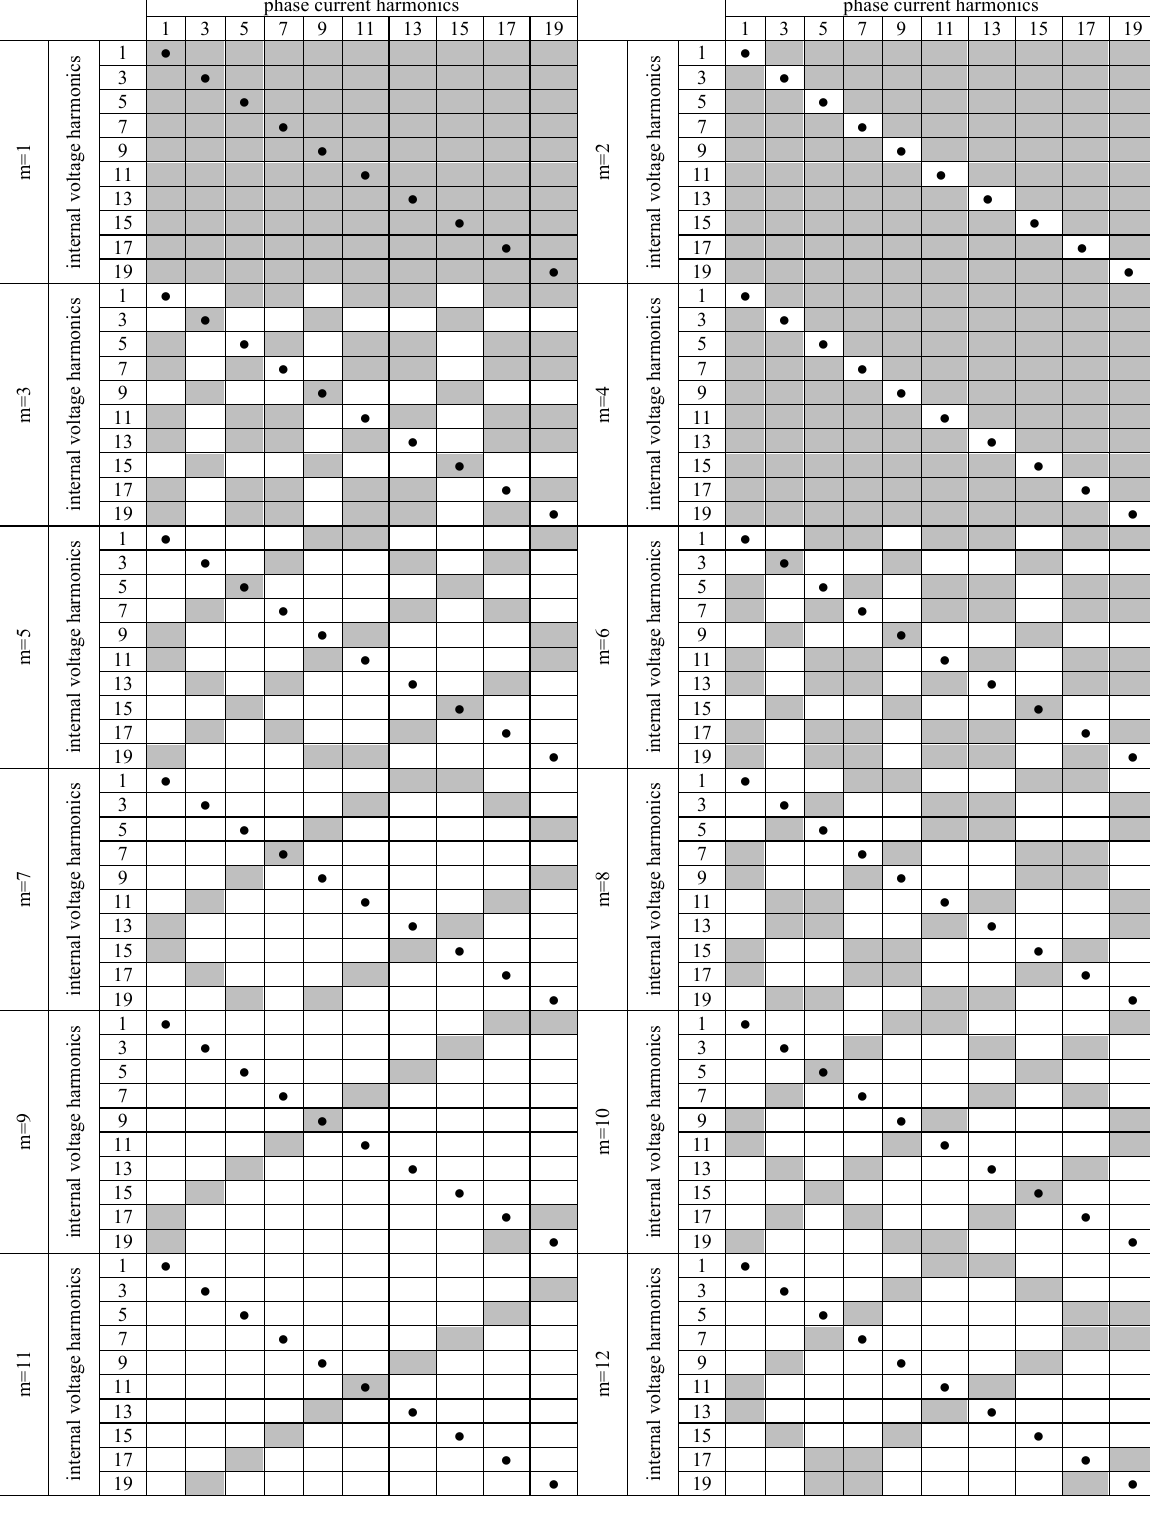
Table 2: Harmonic pairs of internal voltage and phase current affecting the electromagnetic torque ripples of m phase machines phase current